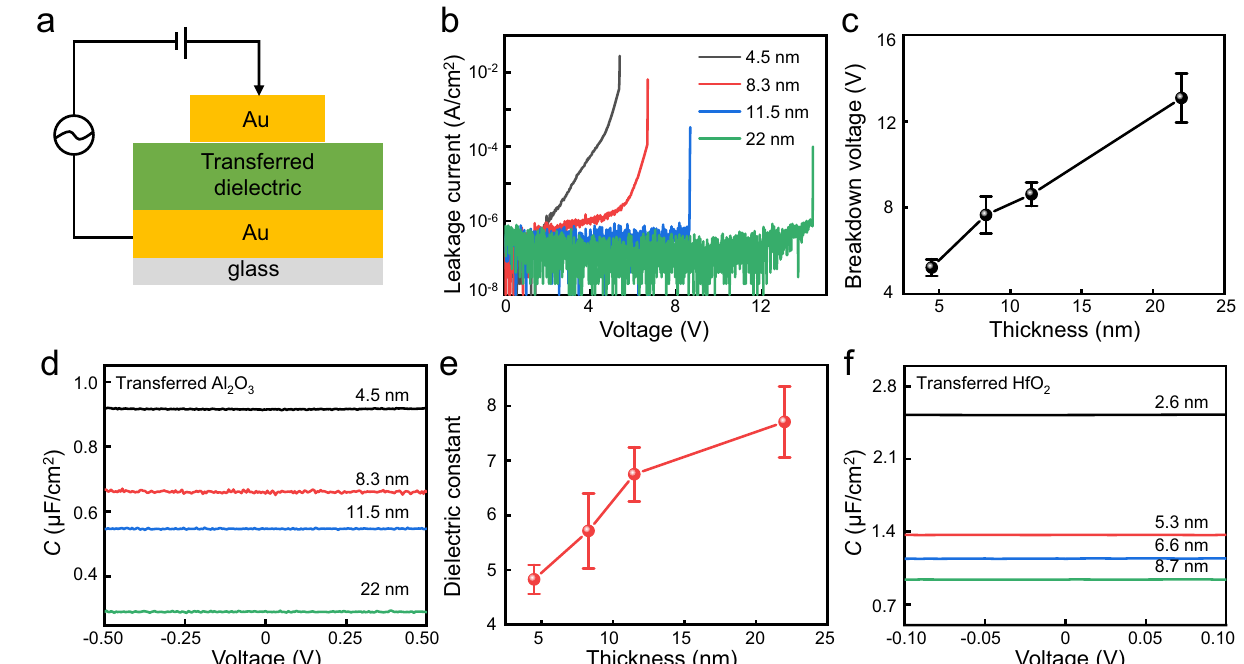
Fig. 2 | Dielectric properties of transferred oxide fi lms. a Schematic of metal- insulator-metal (MIM) device structure for capacitance measurement. b The leak- age current density as a function of applied voltage for transferred Al 2 O 3 with variousthickness.Lowleakagecurrentof10 − 6 A/cm 2 areobservedbeforedielectric breakdown. c Breakdown voltage of the transferred dielectric, where high break- downelectric fi eldover6MV/cmaredemonstrated. d , e Capacitance-voltage(C – V)